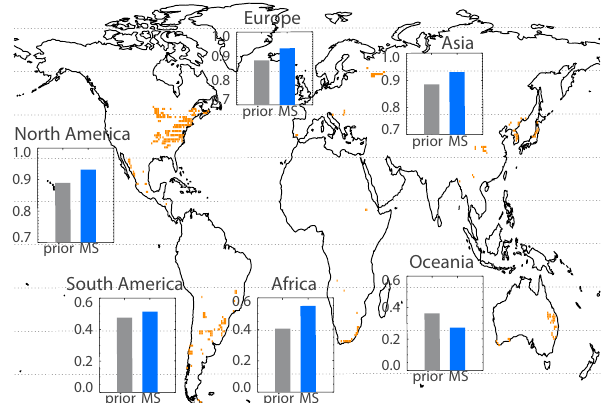
Fig. 9. Continental medians of NDVI/FPAR correlation of prior model (grey) and after MS optimization (blue), using weekly time series for the 2000–2008 period and the ERA-I simulation. Correla- tions are only calculated for boxes with dominant DBF ecosystem and where cycles in NDVI and FPAR are detected (orange boxes on the